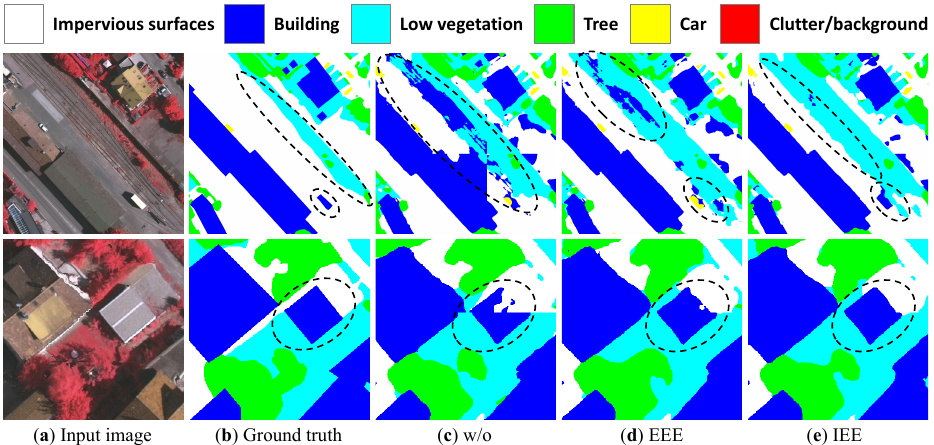
Figure 13. Visualization of explicit and implicit edge enhancement